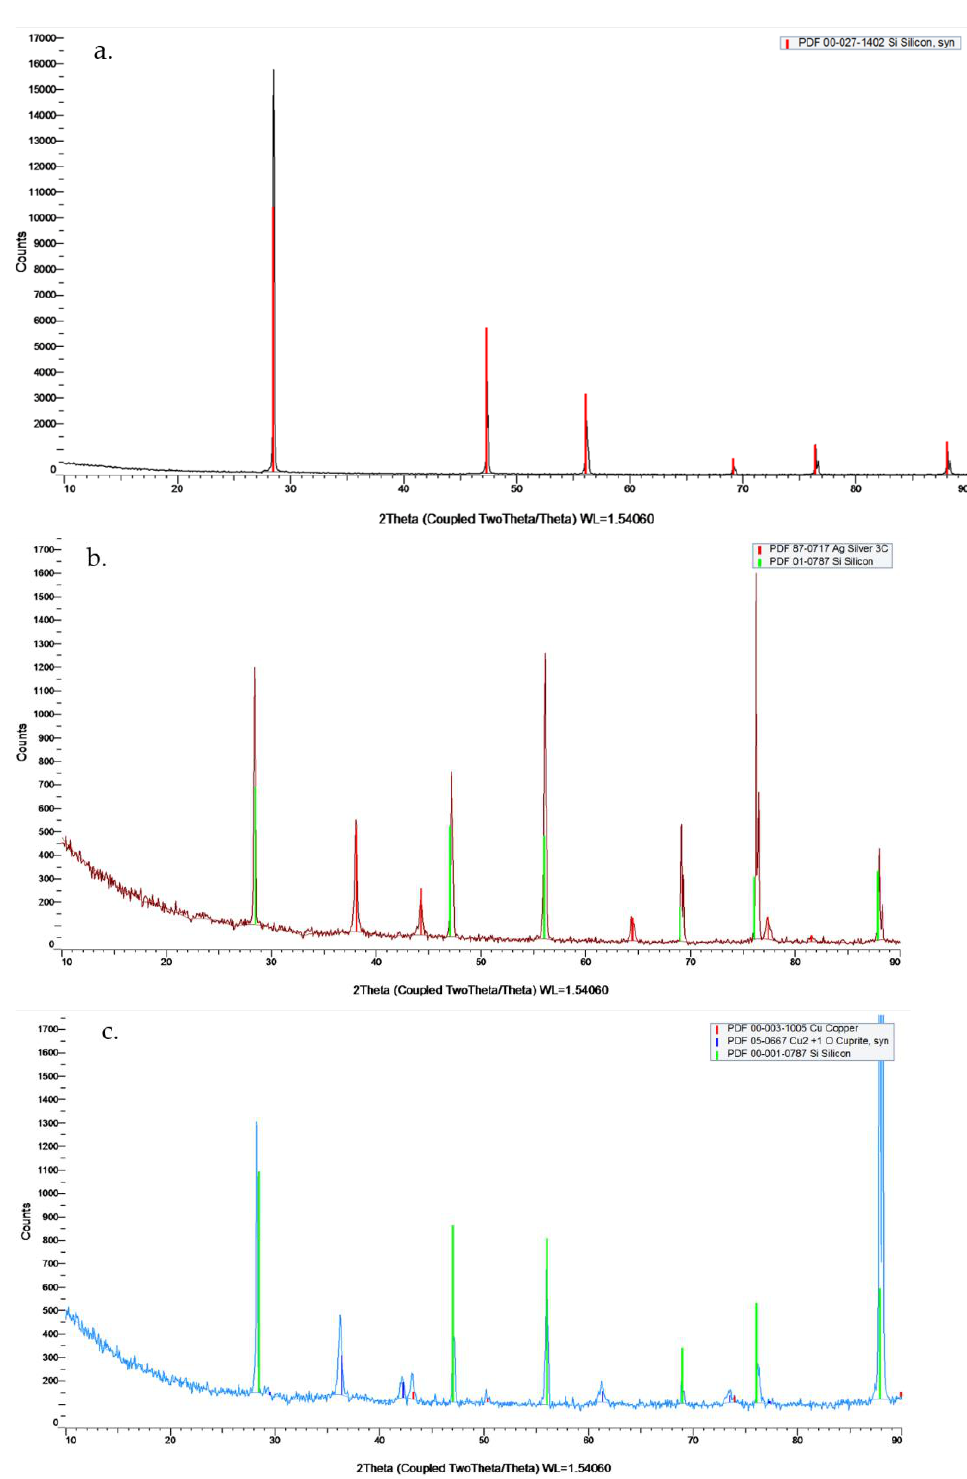
Figure 5. XRD scans of recovered polycrystalline Si ( a ) after cleaning, after etching and doping with ( b ) Ag, ( c ) Cu.